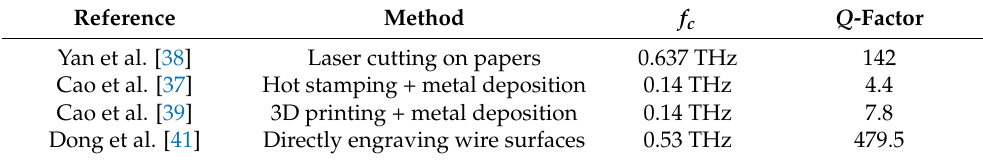
Table 2. The Q -factors of waveguide-integrated Bragg gratings fabricated using different